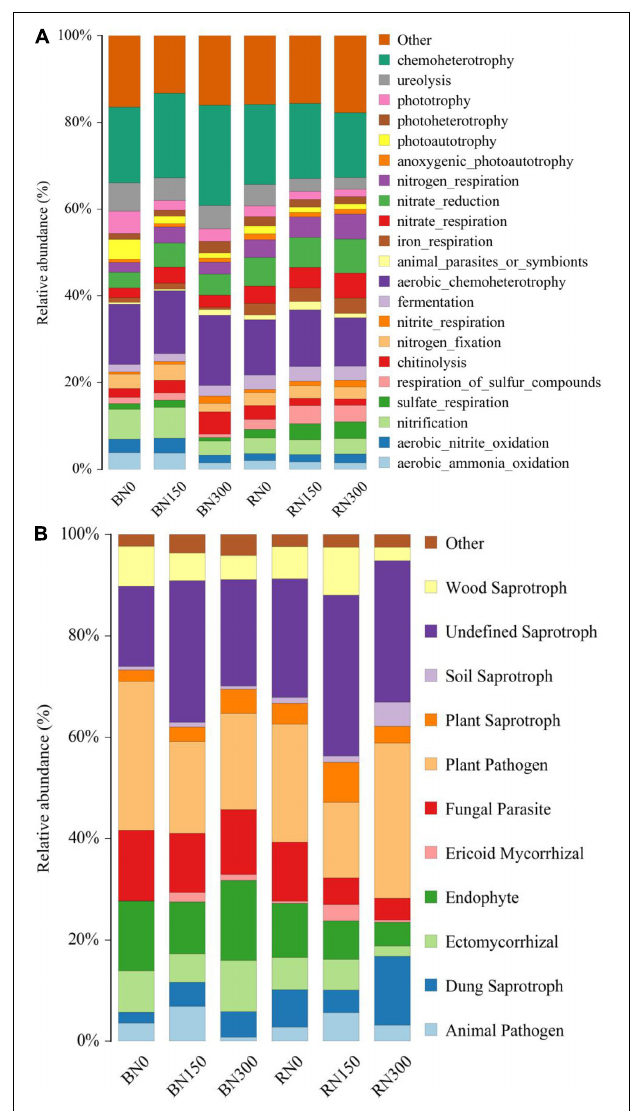
FIGURE 3 | Bacterial (A) and fungal (B) community composition of rhizosphere and bulk soil samples subjected to the three levels of N fertilization.